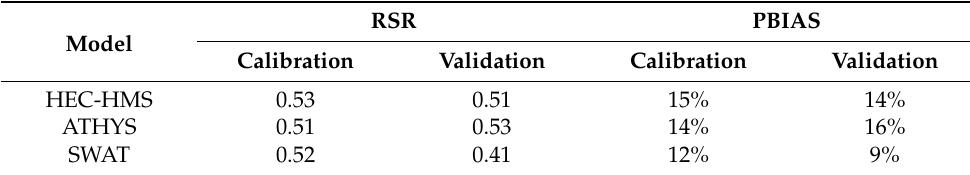
Table 2. RSR and PBIAS values for the calibration and validation